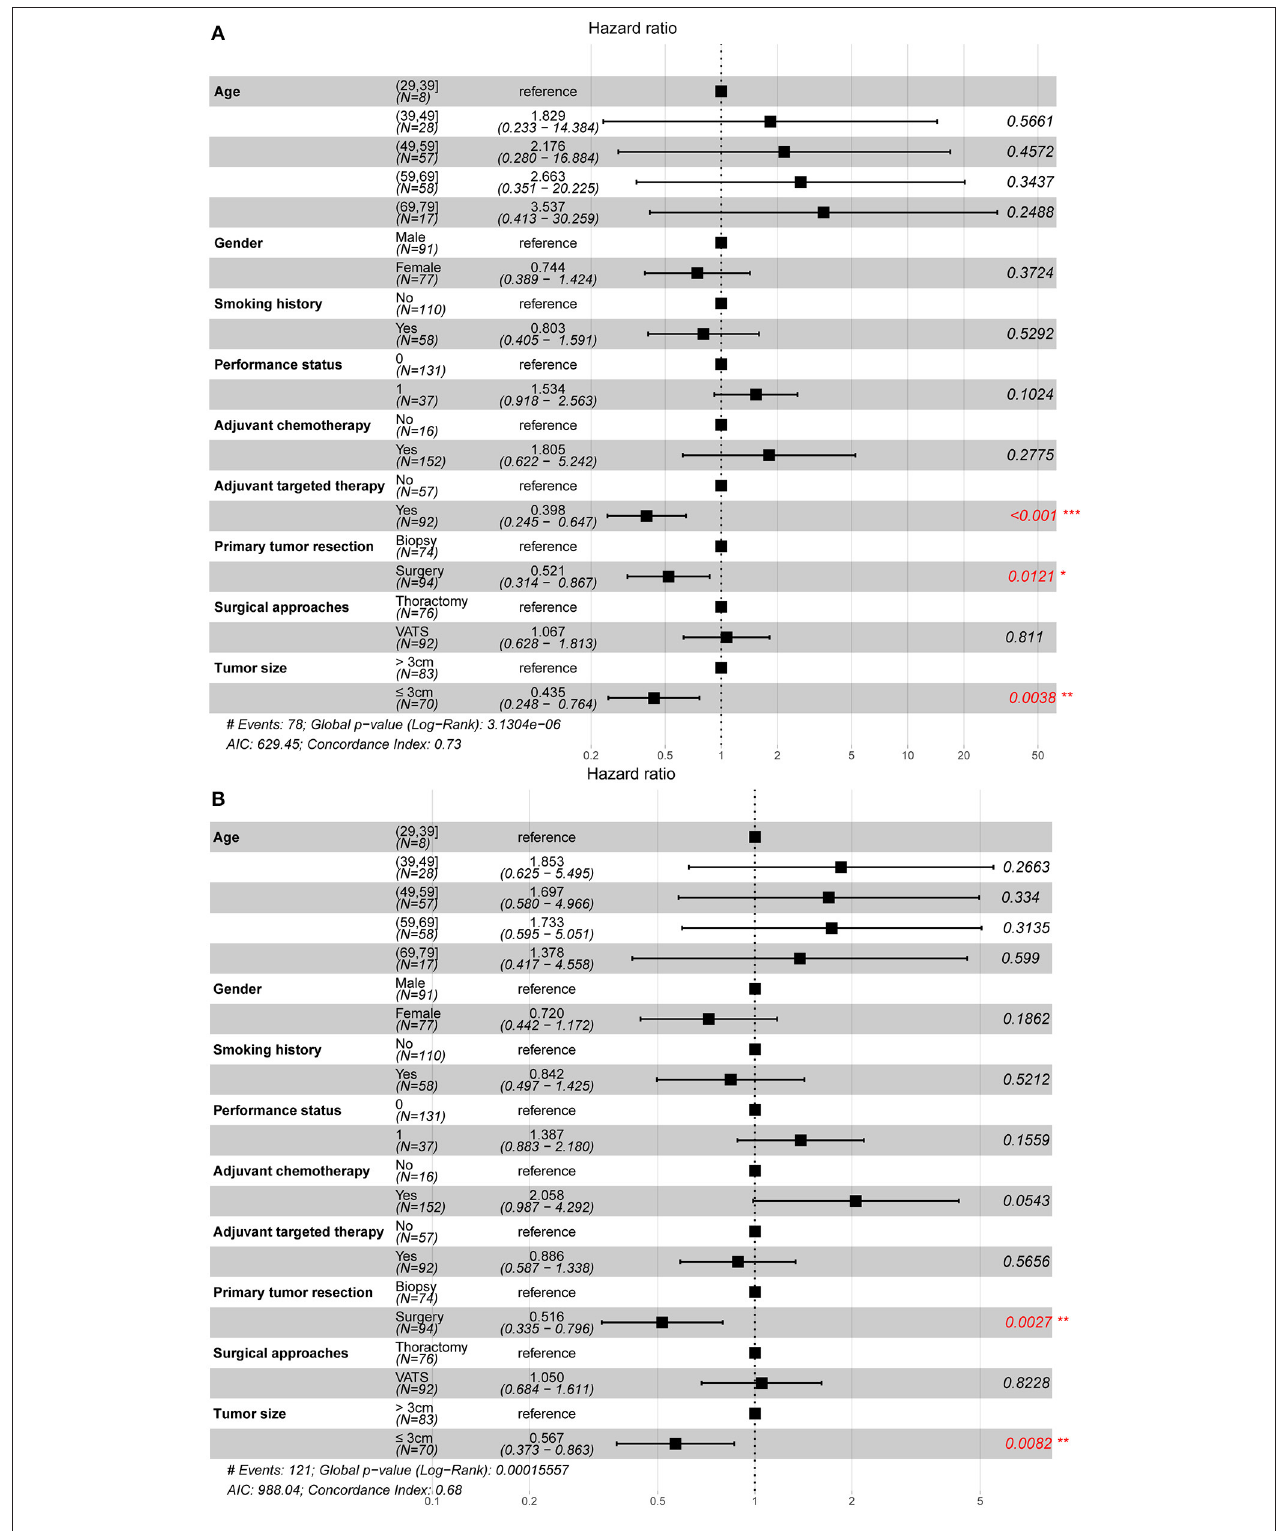
FIGURE 2 | Prognostic factors of non-small cell lung cancer patients with unexpected pleural dissemination after surgery. (A) The forest plot of multivariate Cox regression analysis for overall survival. (B) The forest plot of multivariate Cox regression analysis for progression-free survival. VATS, video-assisted thoracic surgery. *statistically